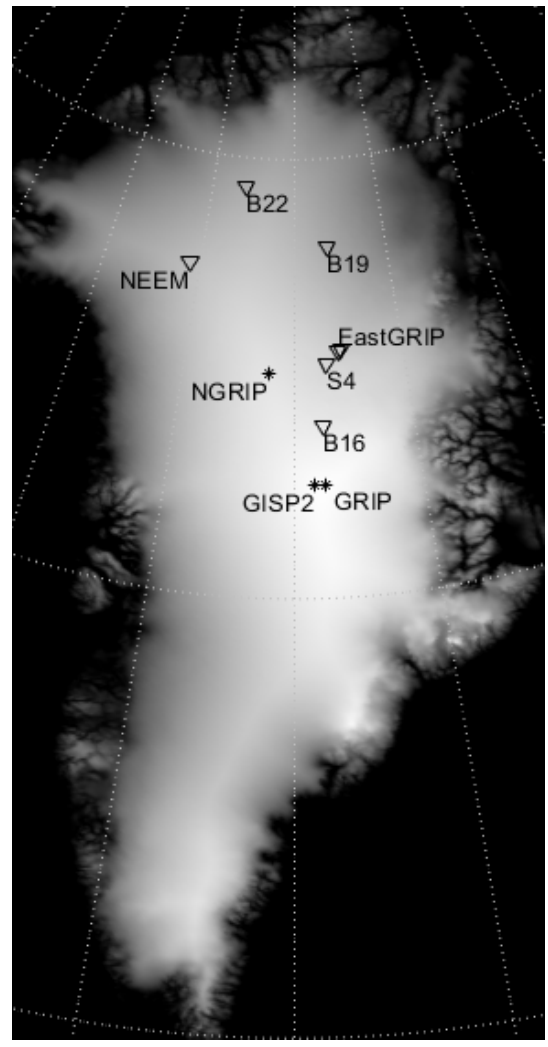
Figure 1. Position of the sites studied using the LISA box (trian- gles). The asterisks indicate deep ice core drilling sites. Note that two sites (S5 and S7) were investigated at EastGRIP. The back- ground altitude map of Greenland is based on the SeaRISE dataset (Bamber, 2001; Bamber et al.,